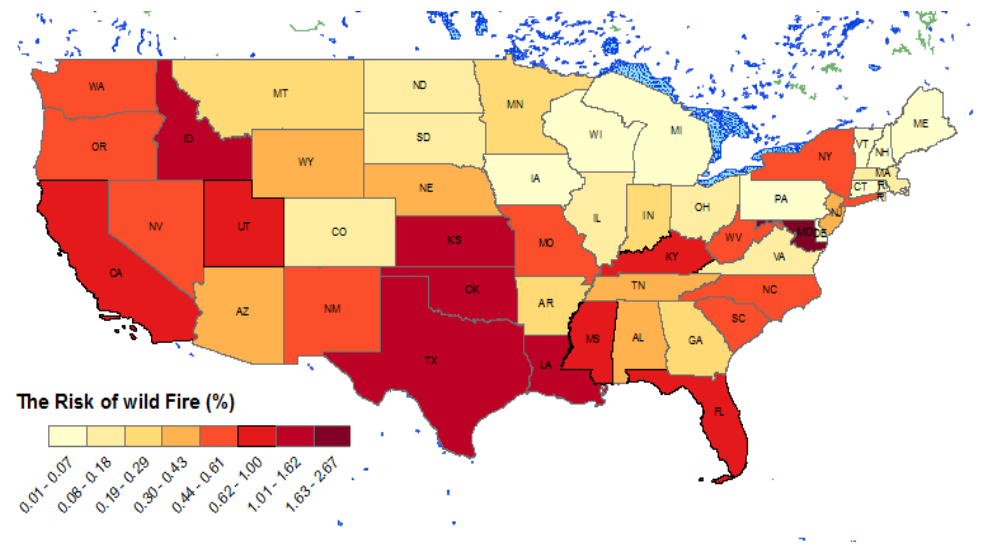
Figure 1. Average annual wildfire risk from 1991 to 1997 in 48 continental US states. The wildfire risk is measured in the percent of area burned by wildfire in total forested